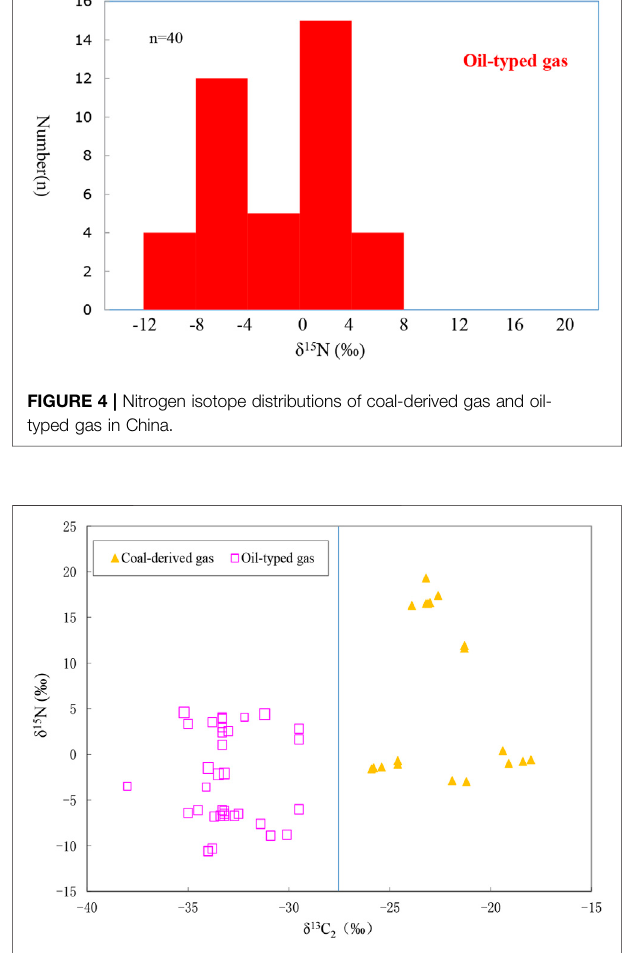
Frontiers in Earth Science |